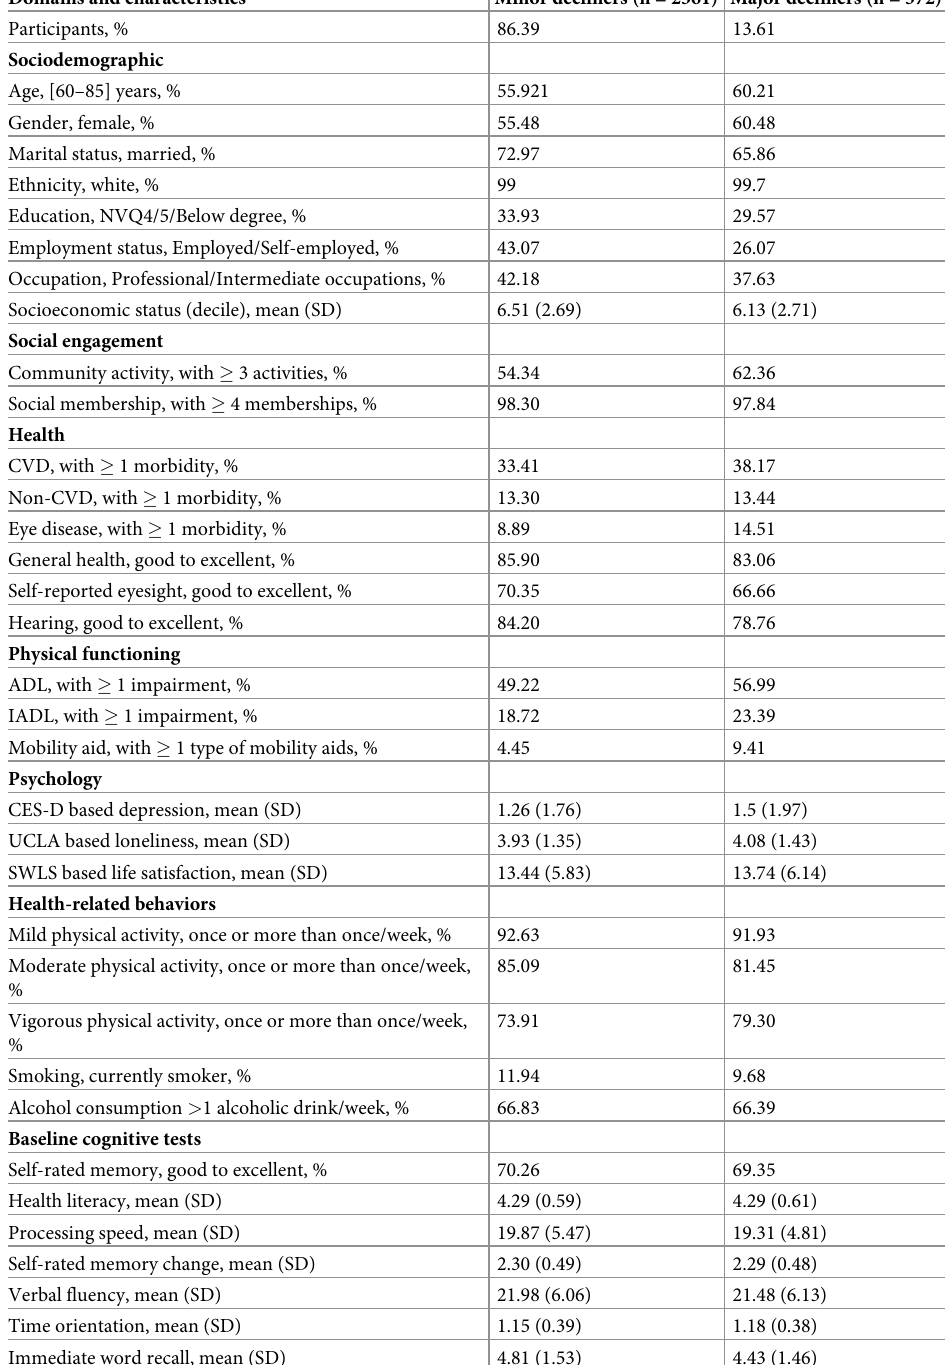
Table 1. Characteristics of the participants in two groups of individuals with major and minor cognitive decline at baseline (wave 2 of ELSA